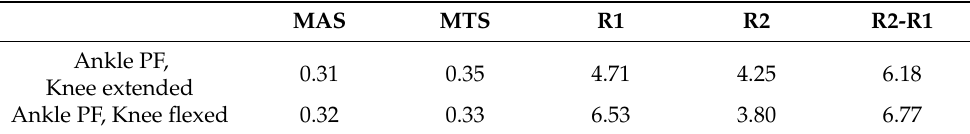
Table 4. Standard error of measurement for the Modified Ashworth Scale and Modified Tardieu